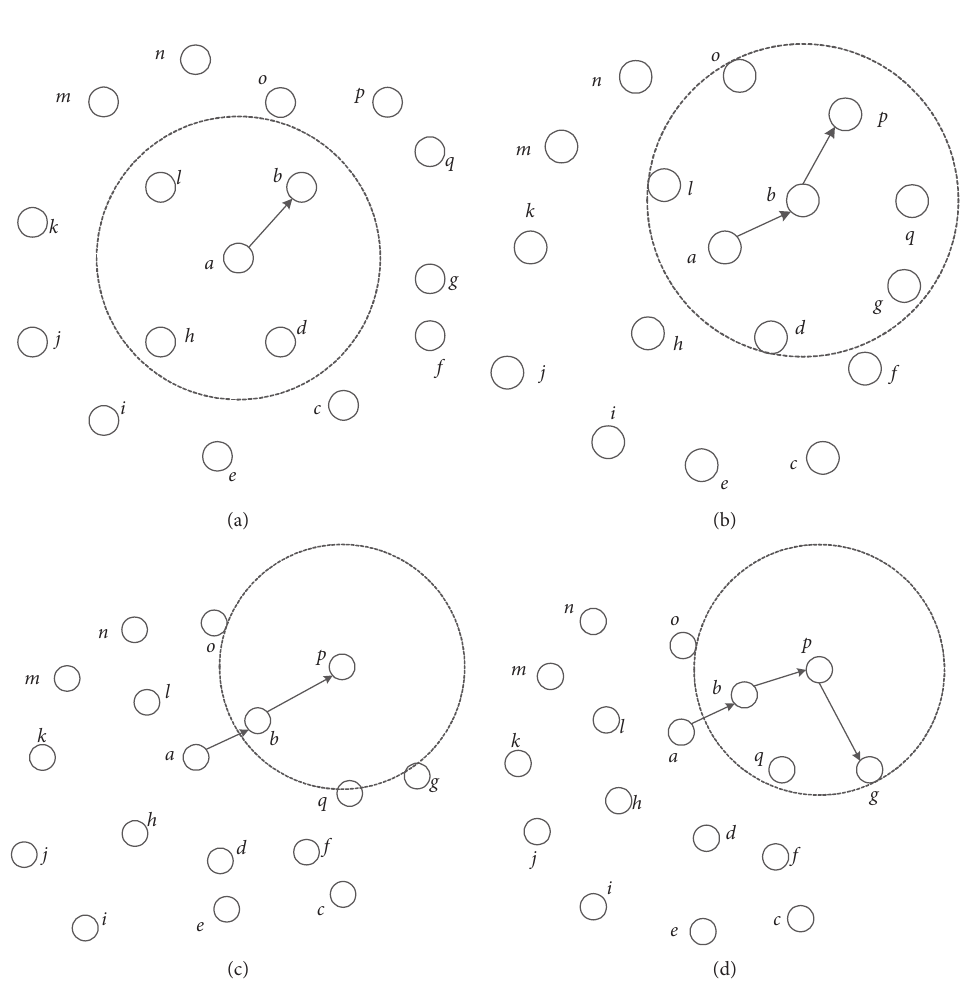
� t � t � t 1 , (b) t 2 , (c) t 3 , and (d) t 4